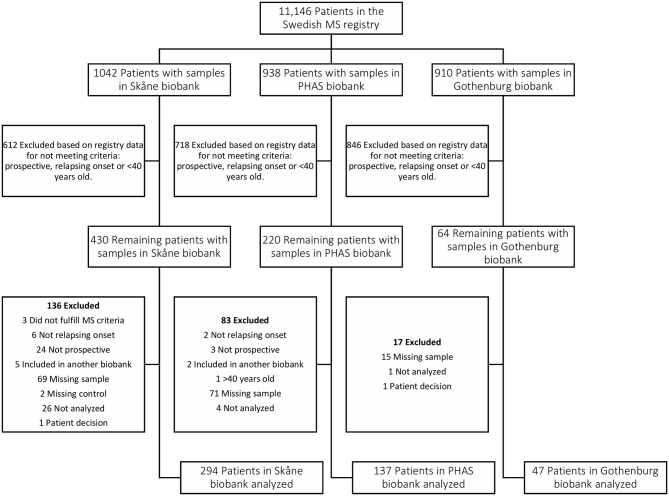
Flow chart depicting identification and selection of patients for inclusion in the Pre-MS cohort. Through crosslinking between the Swedish MS registry and three Swedish microbiological biobanks potential study participants were identified. In the next step all patients that did not have a relapsing onset of MS, had not deposited serum sample before MS debut or were above 40 years old at the time of sampling were excluded. Validation of the information gathered from the Swedish MS registry was performed for 65% of study participants. This, together with some samples missing or having too low volume, resulted in additional patients being excluded.